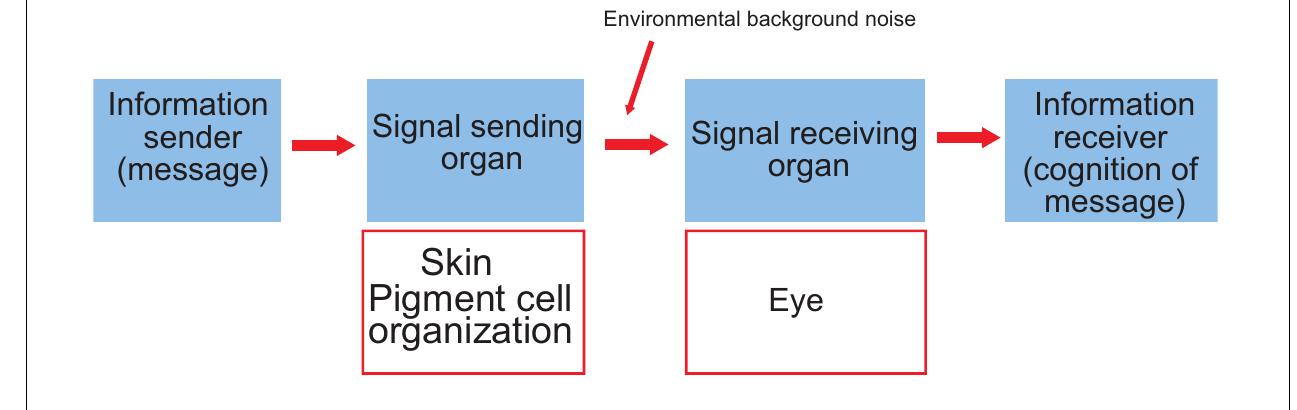
FIGURE 2 | Logical relationship between color producing pigment cell organization and visual signal perception by eye, according to the Shannon – Weaver model of communication (Shannon and Weaver, 1948). Layered organization of pigment cells act as signal transmitter, and eye of predator act as signal receiver.